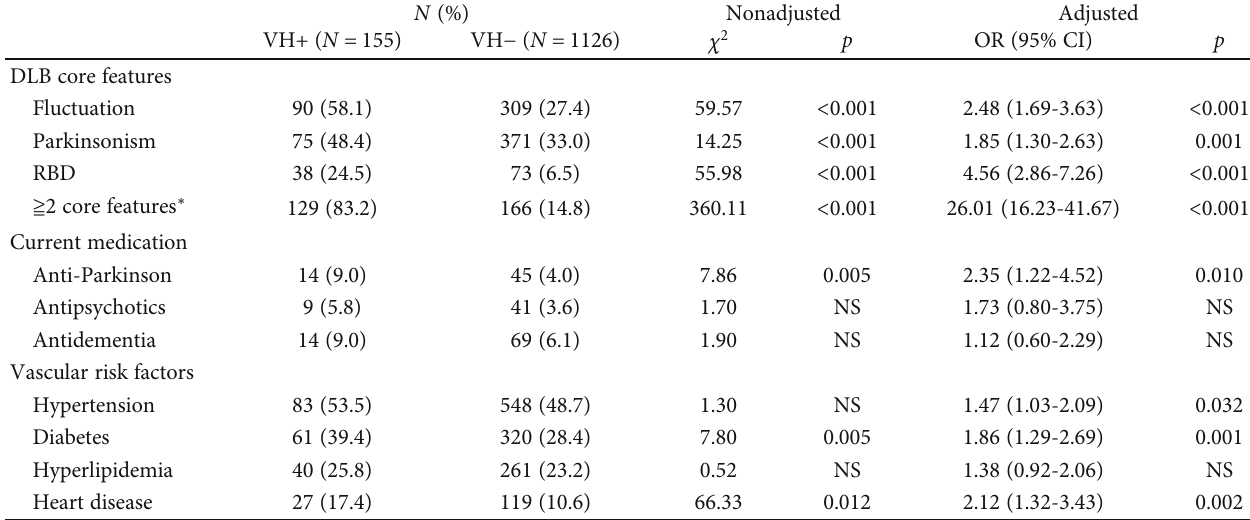
Table 2: Clinical manifestation of VCI patients with or without visual hallucinations (VHs).